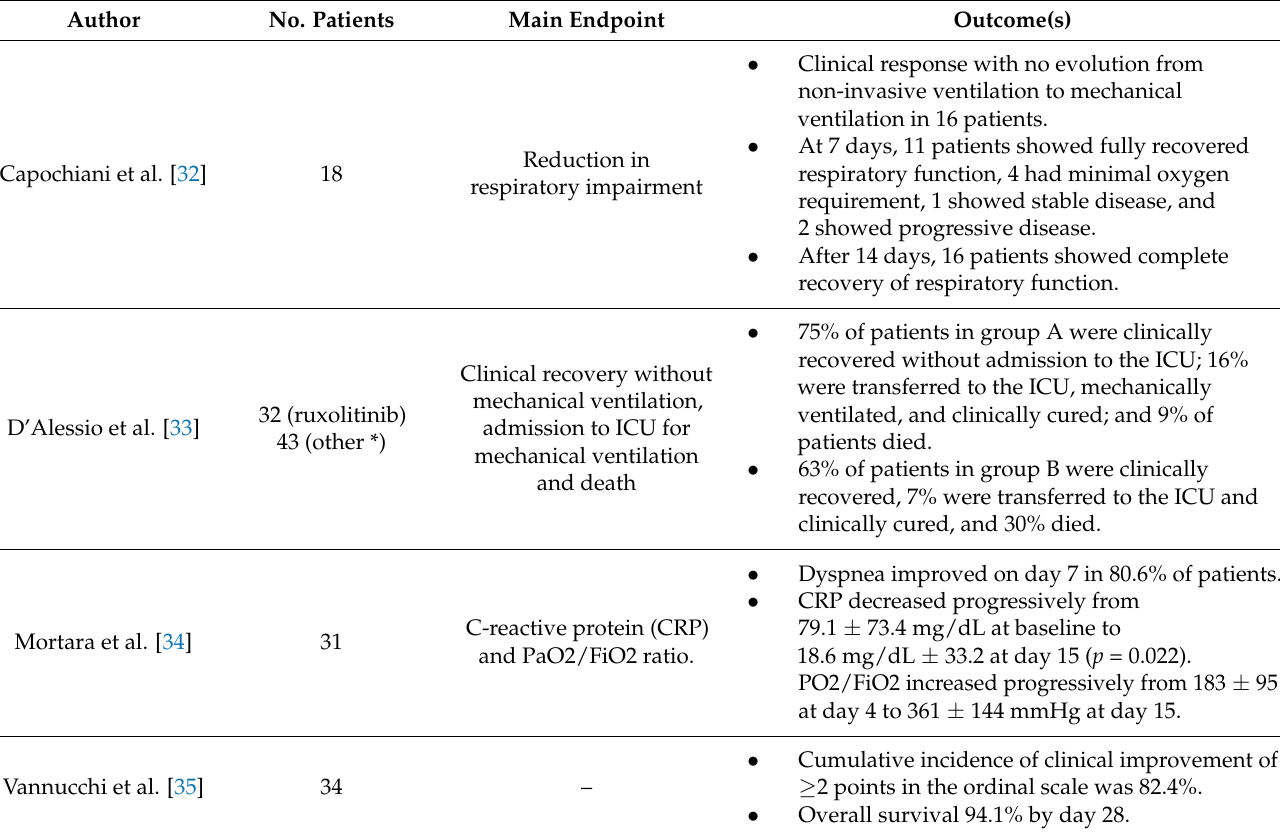
Table 1. Previously published case series on compassionate use of ruxolitinib in patients hospitalized for COVID-19.